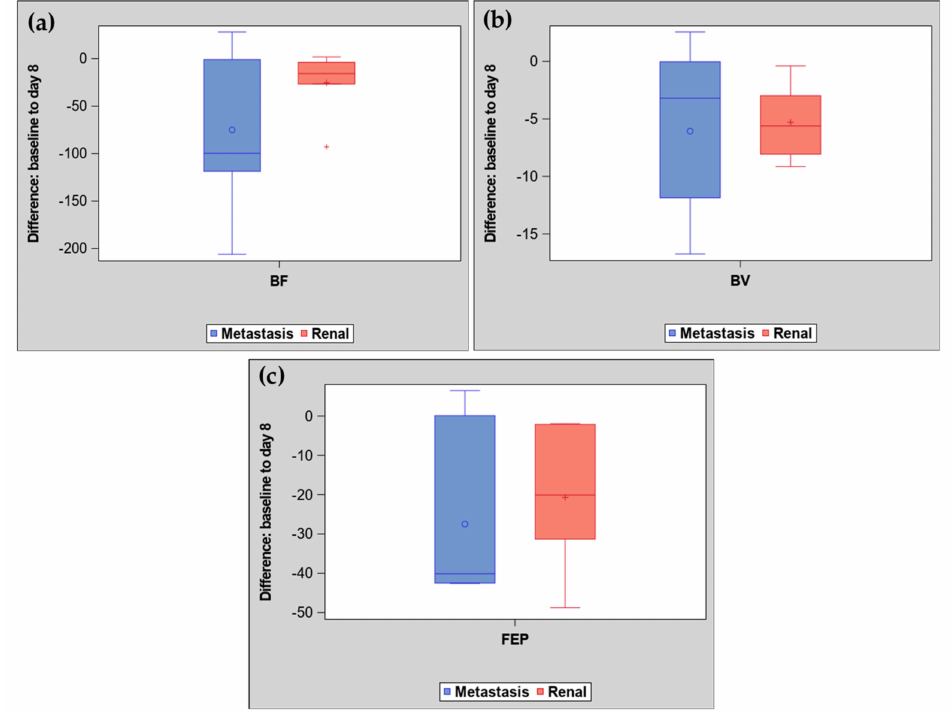
Figure 2. Distribution of di ff erences in computed tomography (CT) perfusion parameters by tumor location. ( a ) Changes between baseline and day eight in blood flow (BF). ( b ) Changes between baseline and day eight in blood volume (BV). ( c ) Changes between baseline and day eight in flow extraction product (FEP). BF, BV and FEP were measured with CT perfusion in patients with primary and metastatic renal cell carcinoma treated with an anti-angiogenic